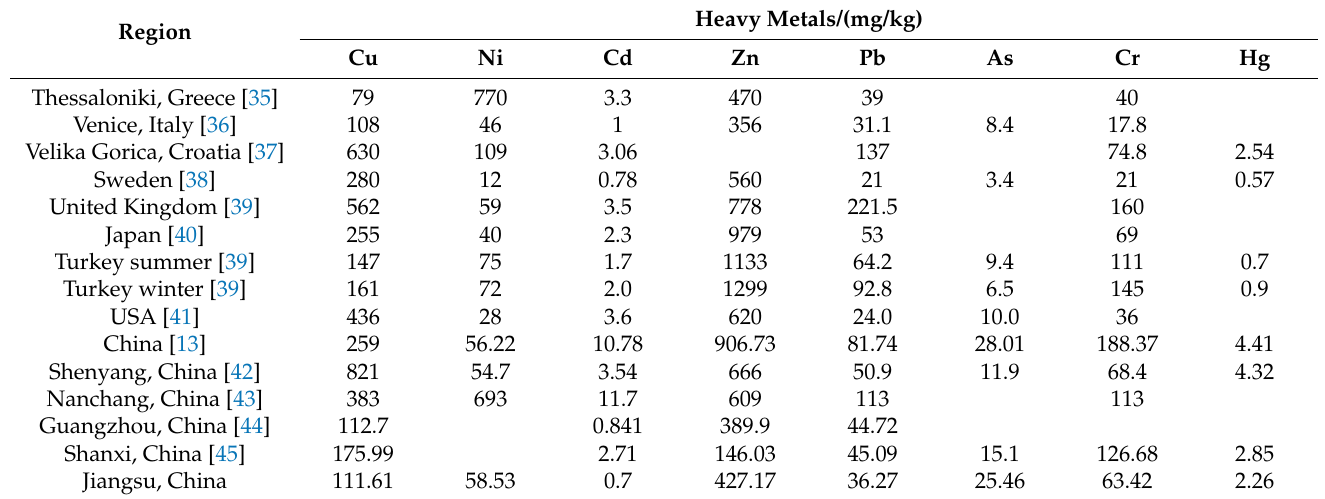
Table 2. Table heavy metal content in different